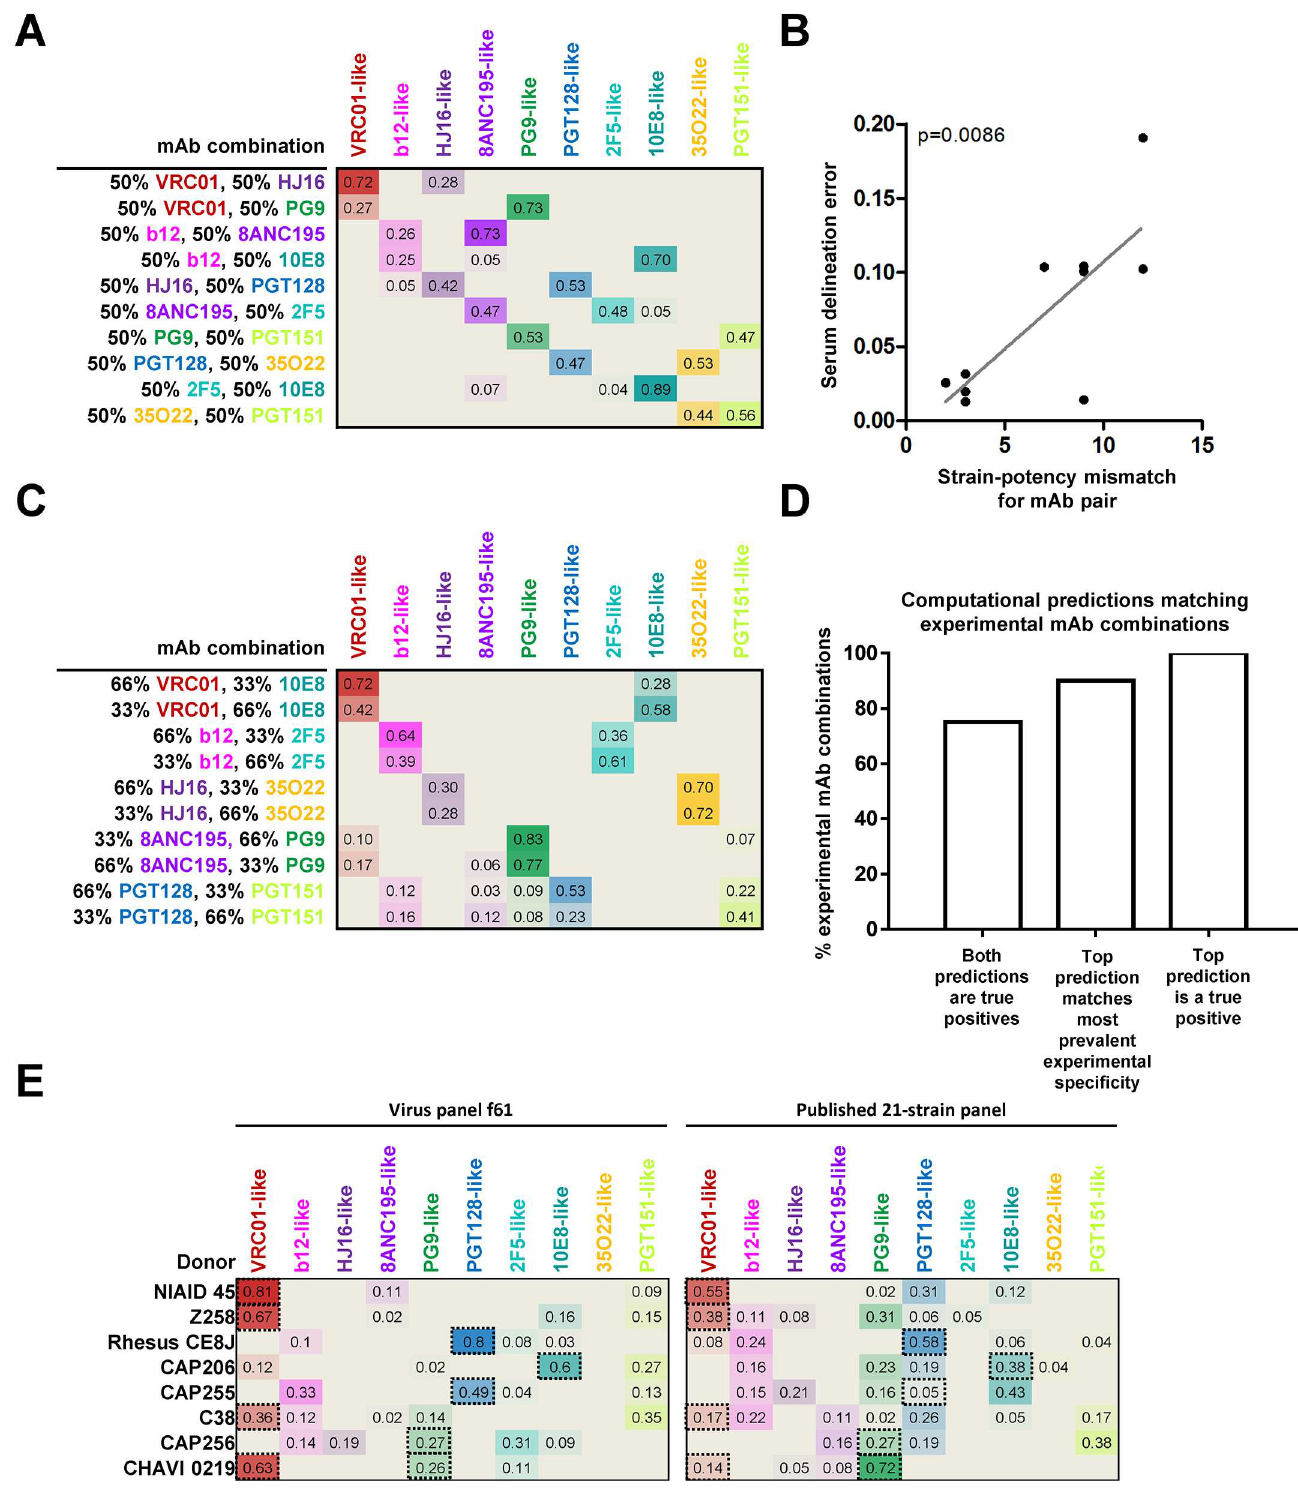
Fig 4. NFP analysis of mAb combinations and donor sera for virus panel f61. (A) NFP predictionsfor ten pairwisemAb combinations (rows), 1:1 ratio. Values shown are the NFP delineationscores for each of ten antibodyspecificities(columns) in each mAb combination; coloredheatmap is proportional to the respectivedelineation scores. (B) Correlation betweenserum delineationerror and strain-potency mismatch for the ten mAb pairs from (A). (C) NFP predictionsfor ten pairwisemAb combinations, 2:1 ratio. (D) Agreement betweenNFP predictions and actual specificitiesfor the